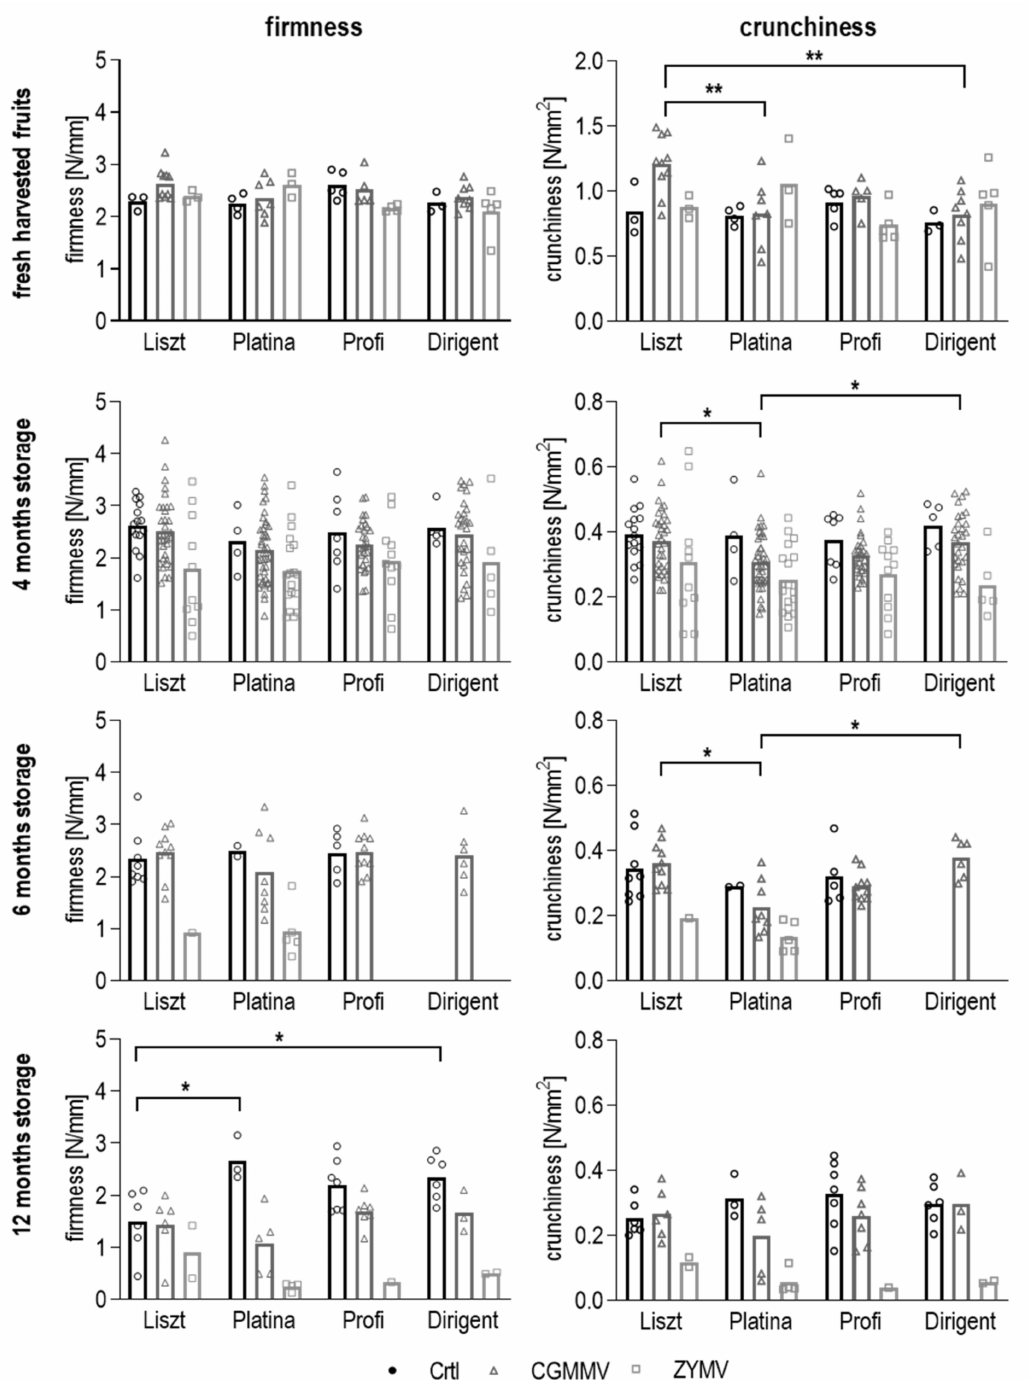
Figure A1. Texture of pasteurized and fresh Cucumis sativus fruits sorted by cultivar. The cucumbers were stored for four, six or 12 months after pasteurization. The cucumbers were harvested from plants with Cucumber green mottle mosaic virus (CGMMV), Zucchini yellow mosaic virus (ZYMV) infection or control plants. The cultivars ‘Liszt’, ‘Platina’, ‘Profi’ and ‘Dirigent’ were used. Firmness (N/mm) and crunchiness (N/mm2) were measured. ANOVA was performed with * p ≤ 0.05, ** p ≤